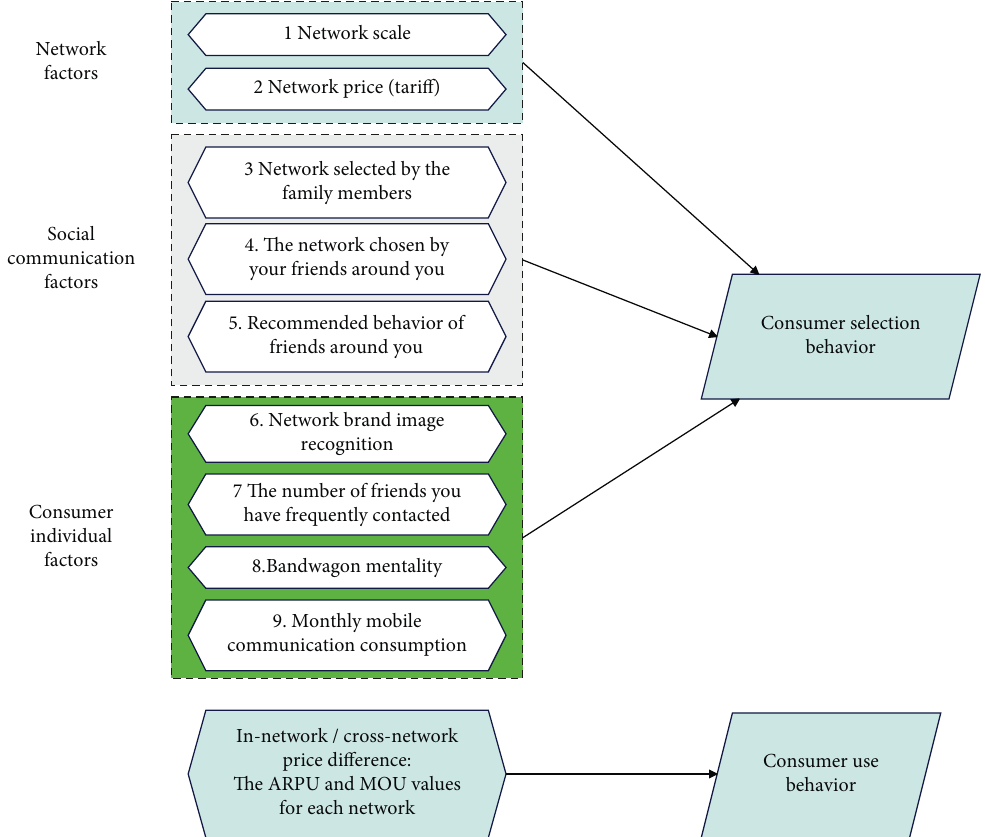
Figure 5: Theoretical framework of mobile communication users’ consumption